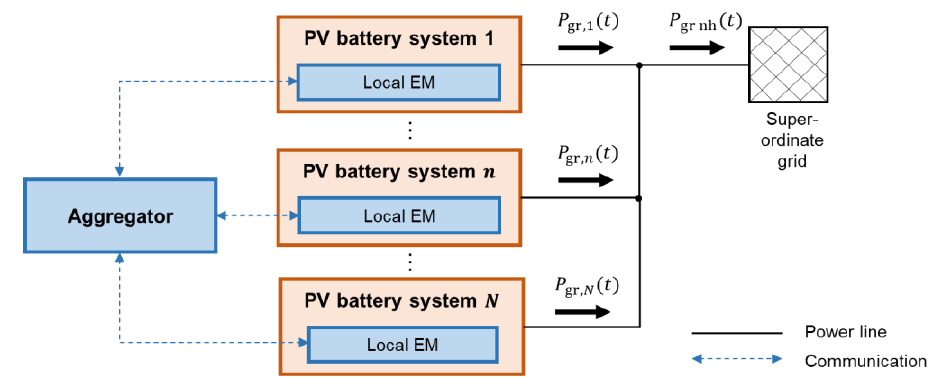
Figure 6. Topology of the neighborhood model of PV battery systems. Table 2. Relevant power flows of the neighborhood of PV battery systems.